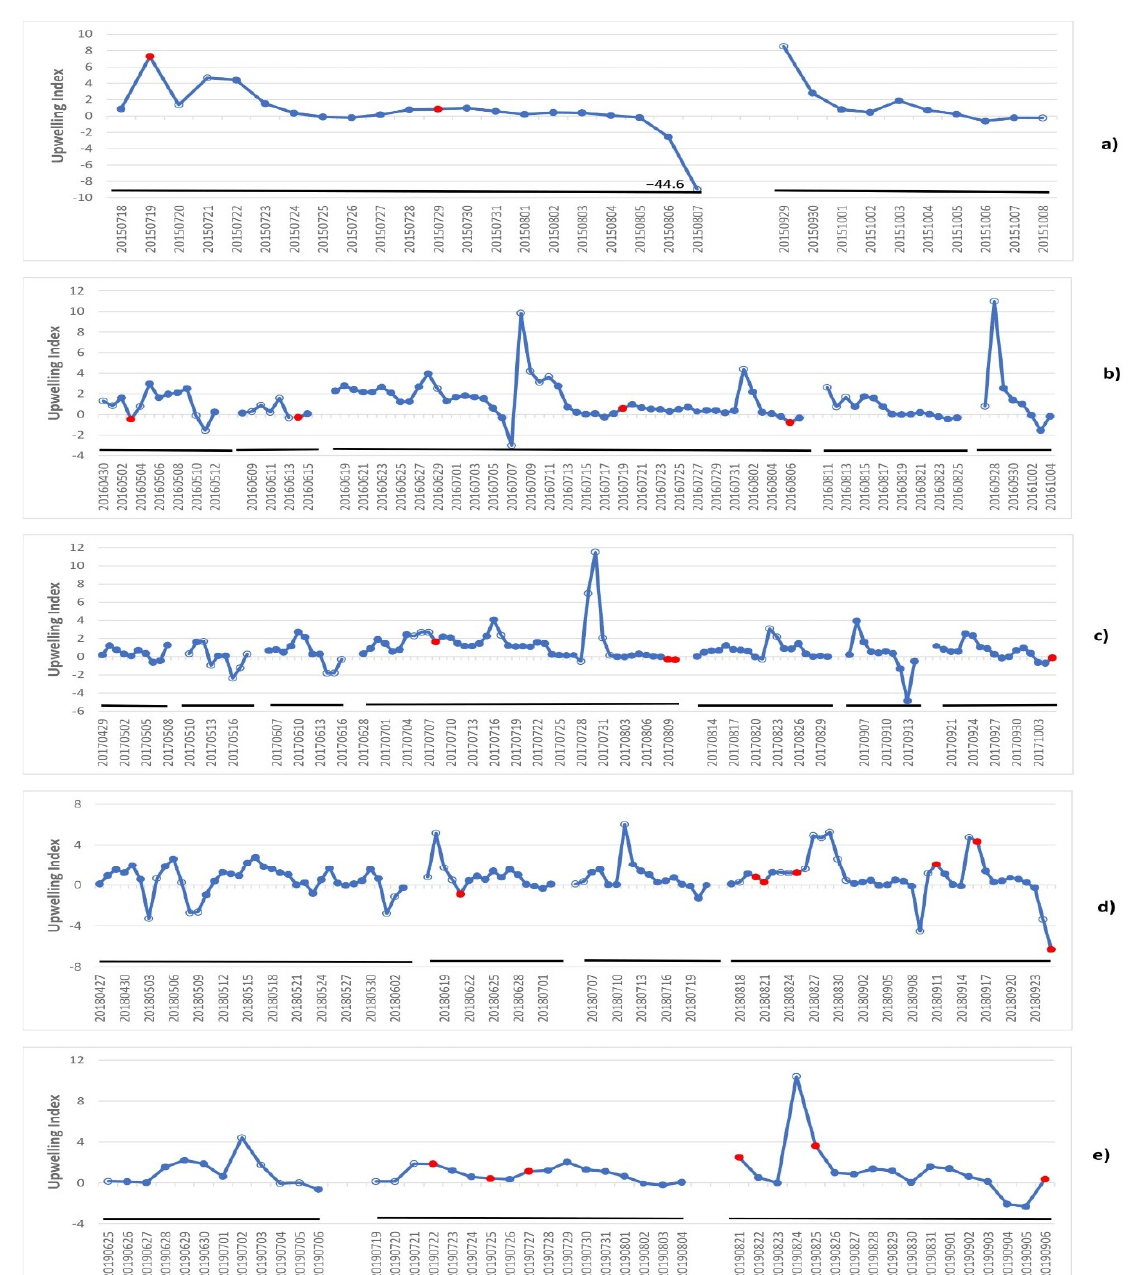
Figure 3. Time-series of the significant upwelling-favorable wind events at the northern location; ( a ) 2015, ( b ) 2016, ( c ) 2017, ( d ) 2018, ( e ) 2019. The solid blue (red) circle indicates that the upwelling (non-upwelling) was detected at the location; while, the un-filled circle indicates that the upwelling status was uncertain because more than 50% of the 20 km buffer has no data in H-8 SST. The labelled value(s) are actual UI value(s) that could not be properly